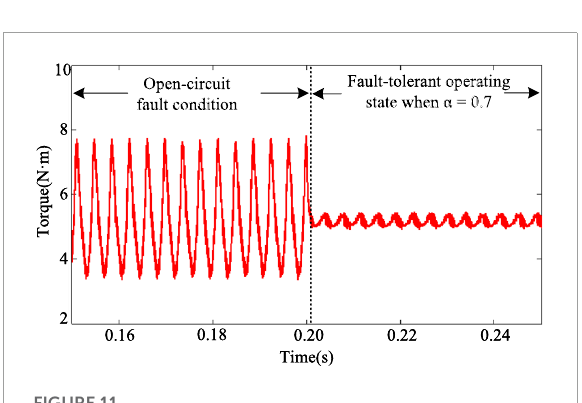
corresponding torque fluctuation can be selected to meet the safe operation of the motor. Meanwhile, the motor runs reliably and smoothly under acceptable conditions for fluctuations after a fault